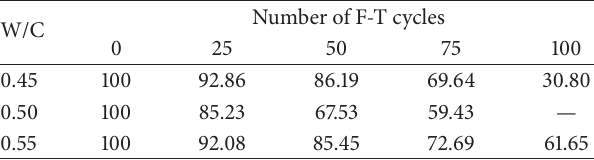
Table 6: Reduced percentage of ultrasonic velocity of plain concrete subjected to F-T cycles.